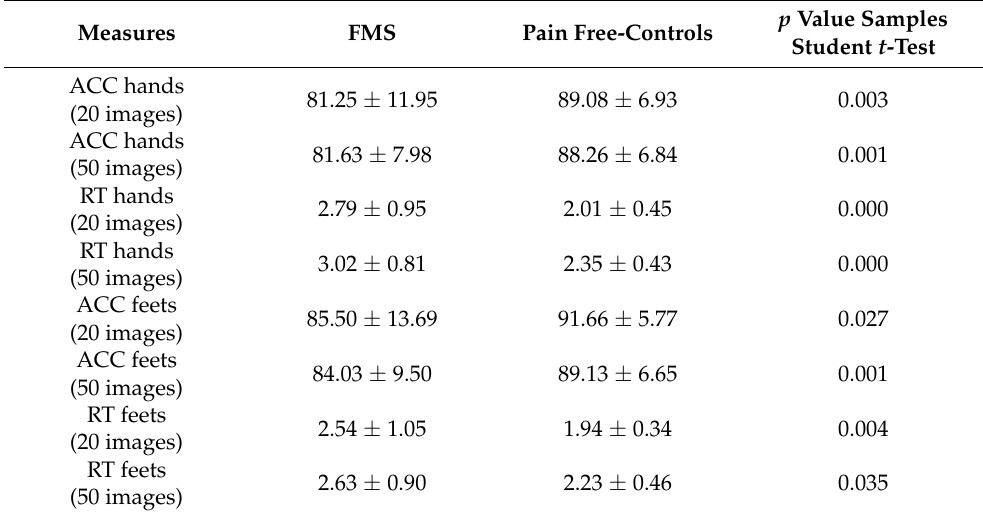
Table 2. Group comparison of right/left judgment performance between FM and pain free